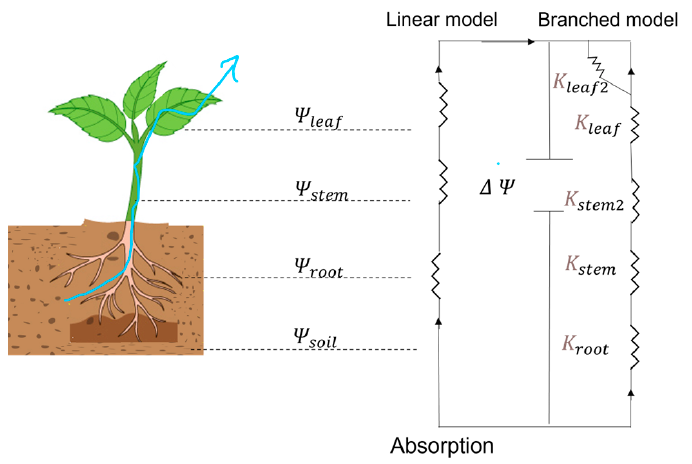
Figure 4. Analogy of Ohm’s law as the resultant conductance (K) of the root, stem, and leaf. An analogy of Ohm’s law in the context of the conductance (K) of plant roots, stems, and leaves might involve considering the plant as a “conductor” of water and nutrients from the soil to the rest of the plant. In this analogy, the conductance of the plant could be thought of as equivalent to the current (I) in Ohm’s law. The “voltage” across the plant (V) could be thought of as the driving force behind the movement of water and nutrients through the plant, and the “resistance” of the plant (R) could be thought of as the factor that impedes or hinders this